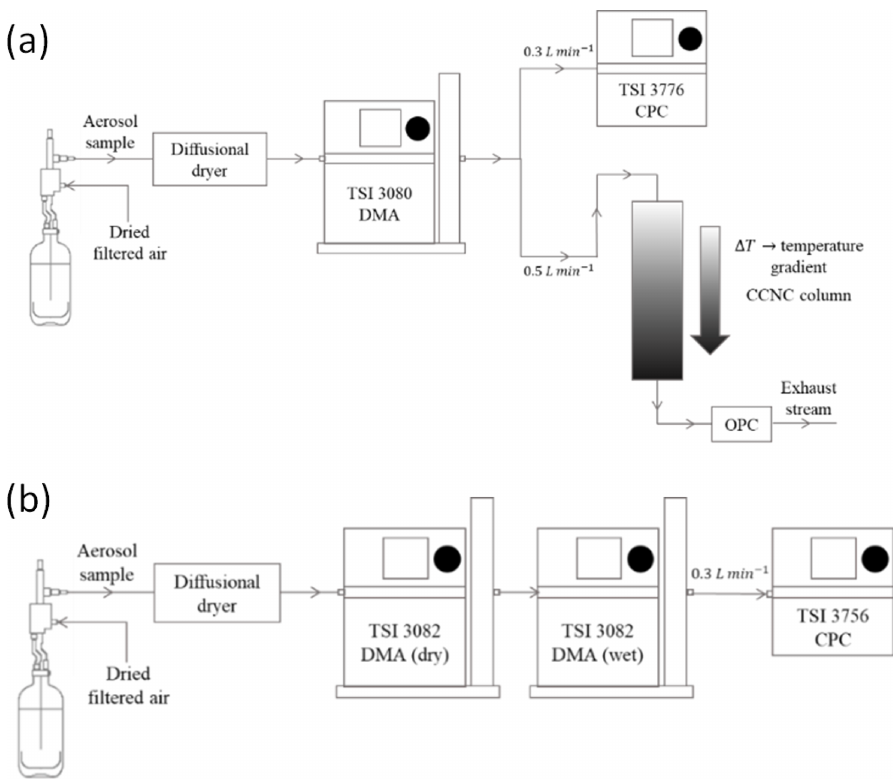
Figure 1. (a) Schematic of a typical CCN measurement setup under supersaturated conditions. The DMA and the CPC collectively operate as an SMPS to obtain a distribution of dry particles. The CCNC is connected in parallel and provides the distribution of activated particles. (b) Schematic of a typical H-TDMA setup for subsaturated droplet growth measurements. The dry DMA (DMA 1) selects dry particles of a specified size. The classified particles are then humidified and passed through the wet DMA (DMA 2) and the CPC operating as an SMPS to generate the droplet distribution.